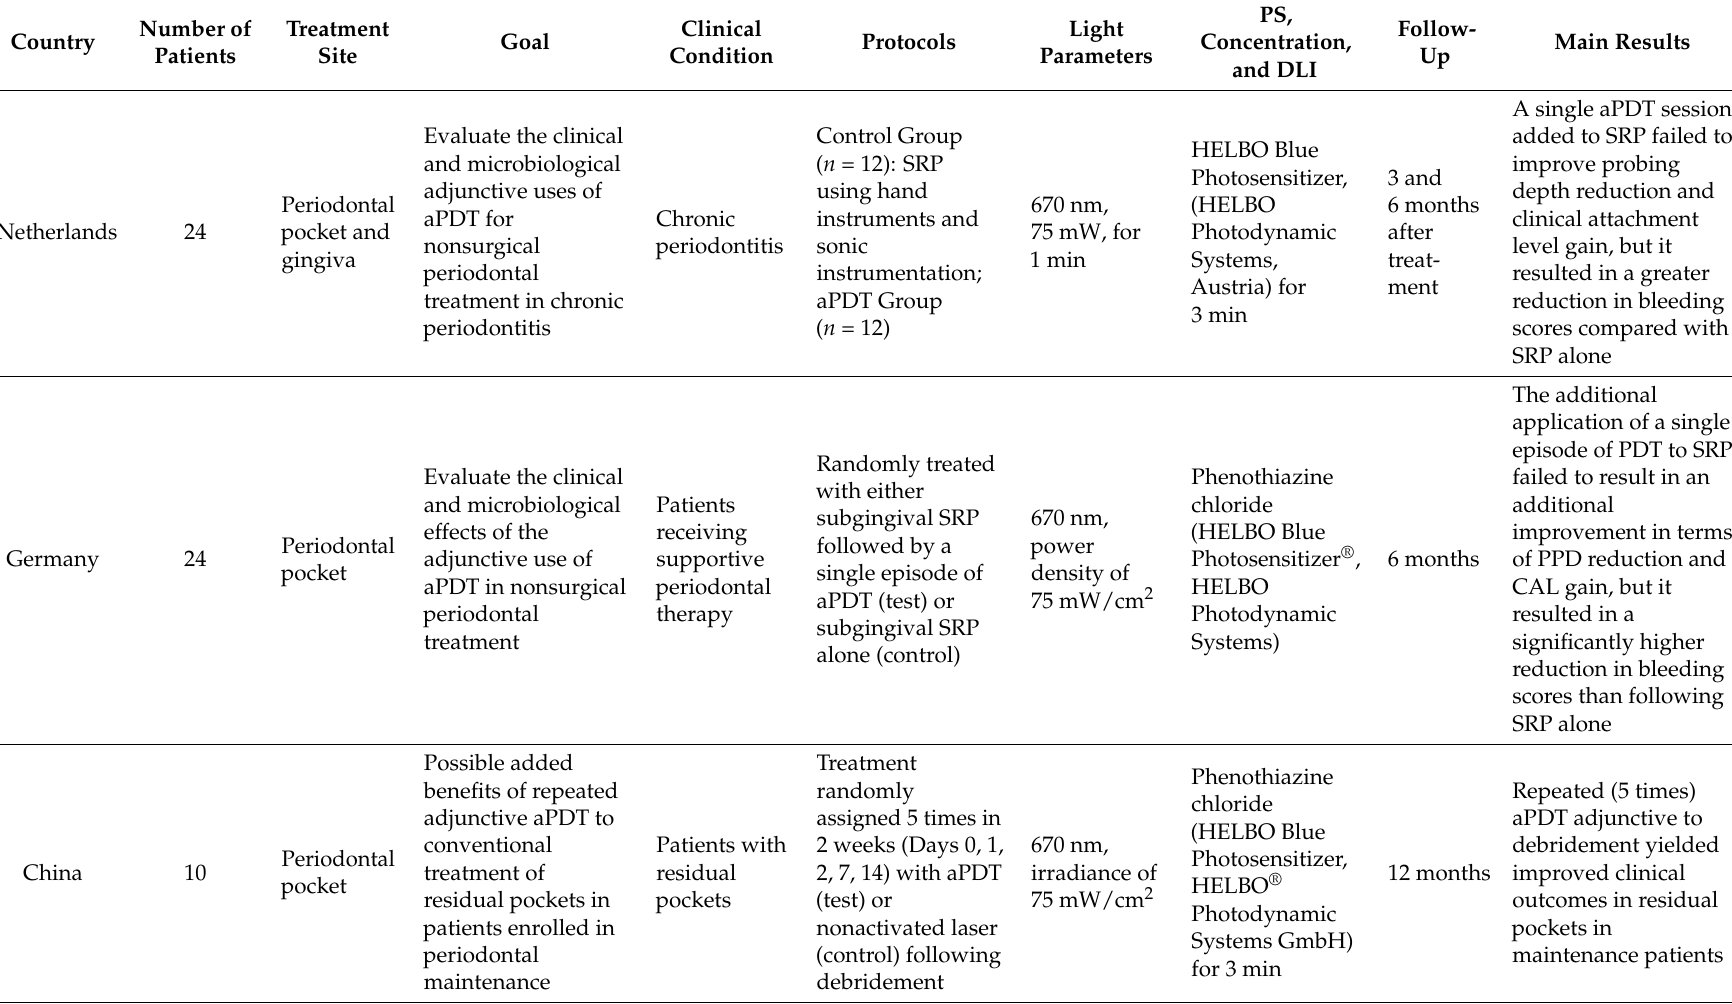
Table 1. Randomized clinical trials that evaluated aPDT for the treatment of periodontal disease. SRP—scaling and root planning.